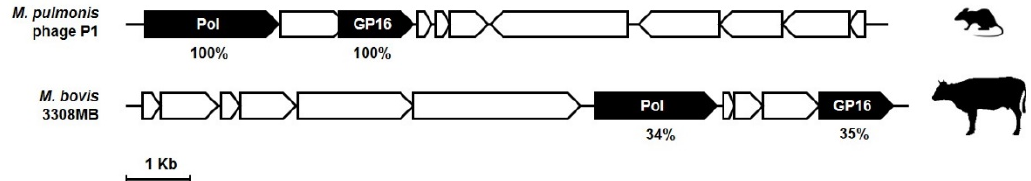
Figure 6. Genomic organization of M. pulmonis phage P1 and putative fingerprint of a P1-like phage attack in M. bovis 3308MB. Black arrows indicate CDSs in phage P1 displaying some similarity with sequences of the 3308MB draft genome. The percentage of global similarity was determined by using the EMBOSS Needle alignment tool. The letter code in black arrows refers to the CDS products. Pol, DNA polymerase GP16, DNA encapsidation protein. Animal icons are used to illustrate the host tropism of M. pulmonis and M. bovis .